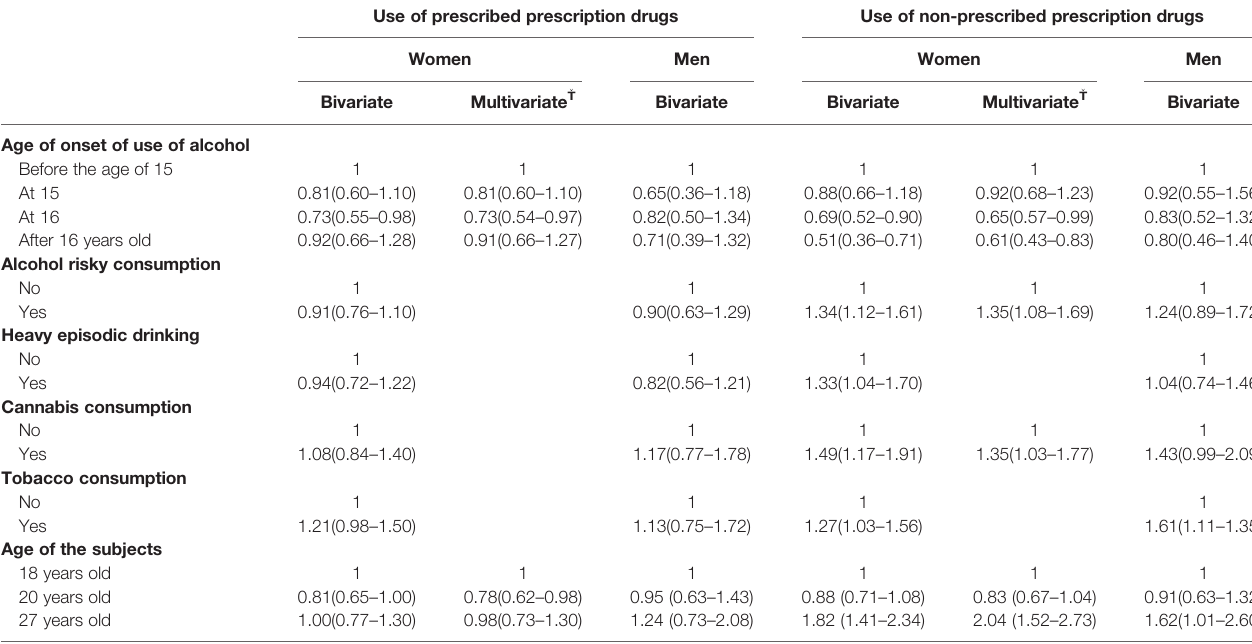
TABLE 4 | In fl uence of substance use on the consumption of prescription drugs. Logistic